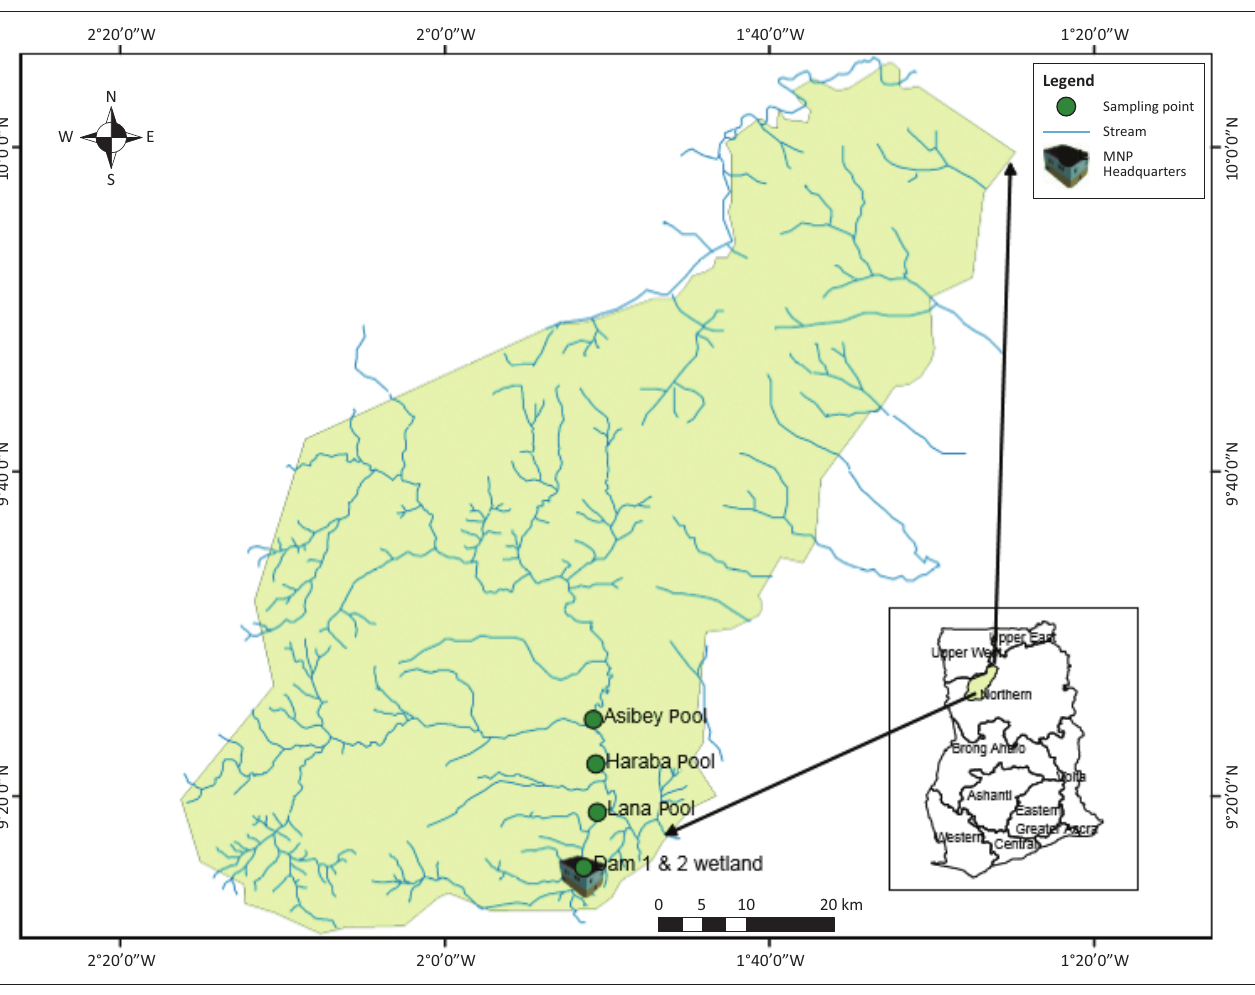
FIGURE 1: Map of Mole National Park showing the study